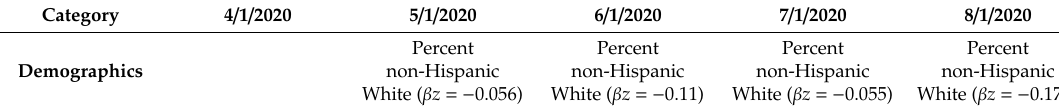
Table 2. Variables chosen by lasso analysis across time points of the COVID-19